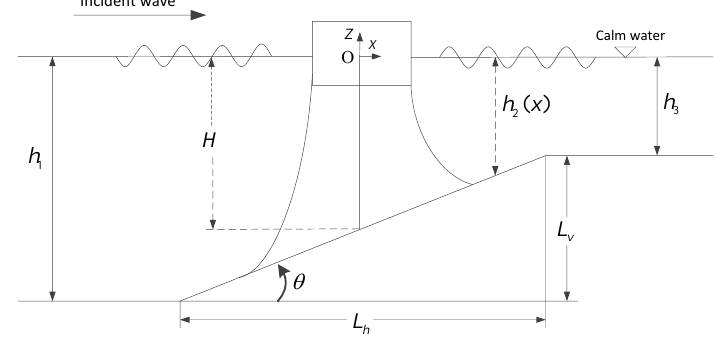
Figure 3. Definitions and illustration of the floating body-mooring line